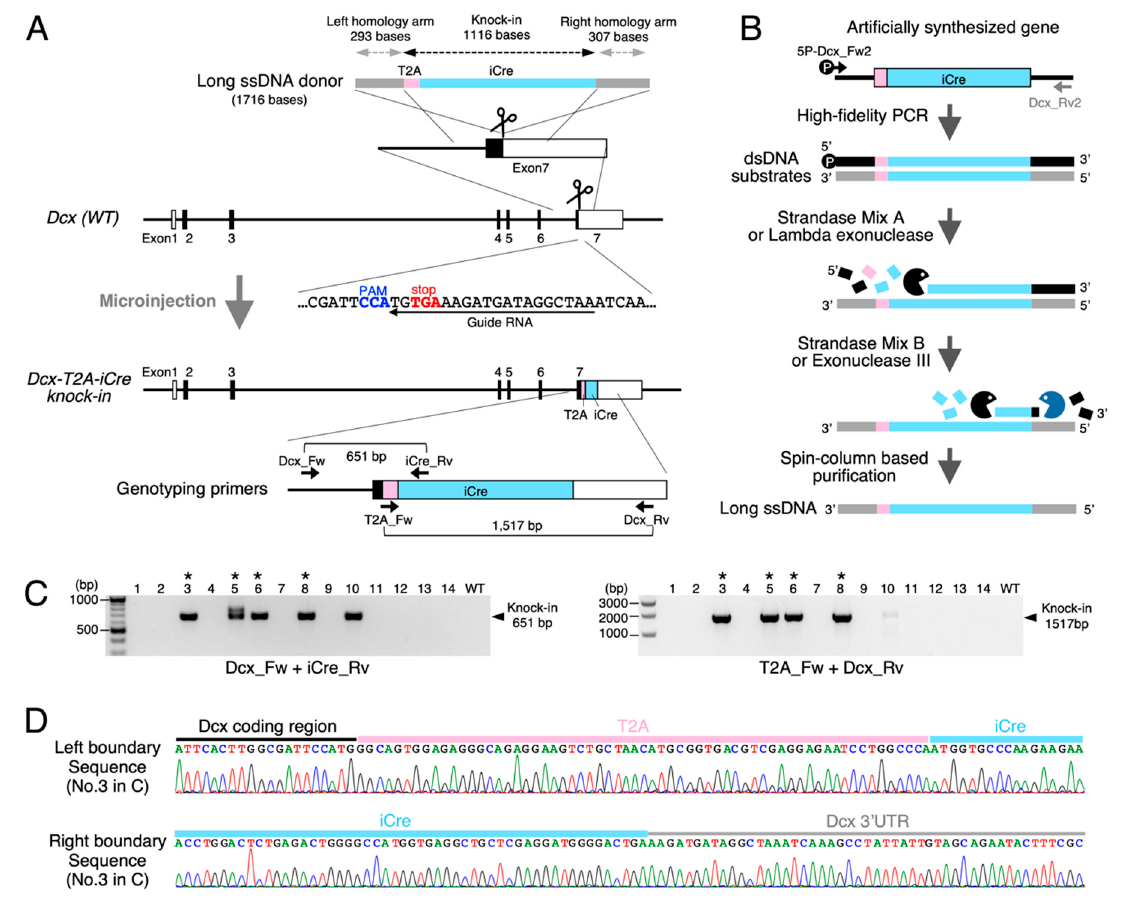
Figure 2. Mouse Dcx locus as a model site for targeted recombinase knock-in. ( A ) Targeting strategy to insert an iCre recombinase cassette just upstream from the translational stop codon in the Dcx gene is outlined. Schematic of the Dcx gene structure, the guide RNA sequences, and the long ssDNA donor is shown in the upper half. The resulting knock-in allele and its genotyping primers are depicted in the lower half. T2A peptide sequences were employed for bicistronic iCre expressions in Dcx-expressing cells. ( B ) The flowchart of long ssDNA production for Dcx-T2A-iCre knock-in via the phospho-PCR method is depicted. The artificially synthesized gene containing a T2A-iCre cassette was used as the template for phospho-PCR. 5 ′ -phosphorylated strands of the PCR products were sequentially digested by Lambda exonuclease and Exonuclease III to yield long ssDNA donor. ( C ) PCR screening results for knock-in newborns derived from the pronuclear injection shown in Table 2 (Dcx-T2A-iCre) are summarized. Two pairs of primers depicted in ( A ) were used to confirm the designed knock-in. Dcx_Fw and Dcx_Rv were designed outside from the donor DNA’s homology arms to exclude the detection of unintended random integrations. Asterisks indicate the knock-in founders with correct insertions (No.3, No.5, No.6, and No.8). No.5 carried an additional incorrect knock-in allele. ( D ) Boundary sequences between the Dcx gene and T2A-iCre cassette analyzed by using the genome DNA from No.3 founder in ( C ) are aligned.